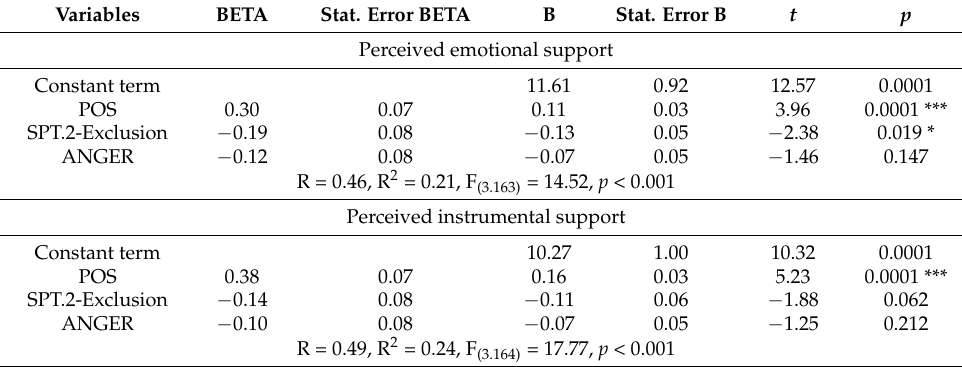
Table 4. Determinants of variables for perceived